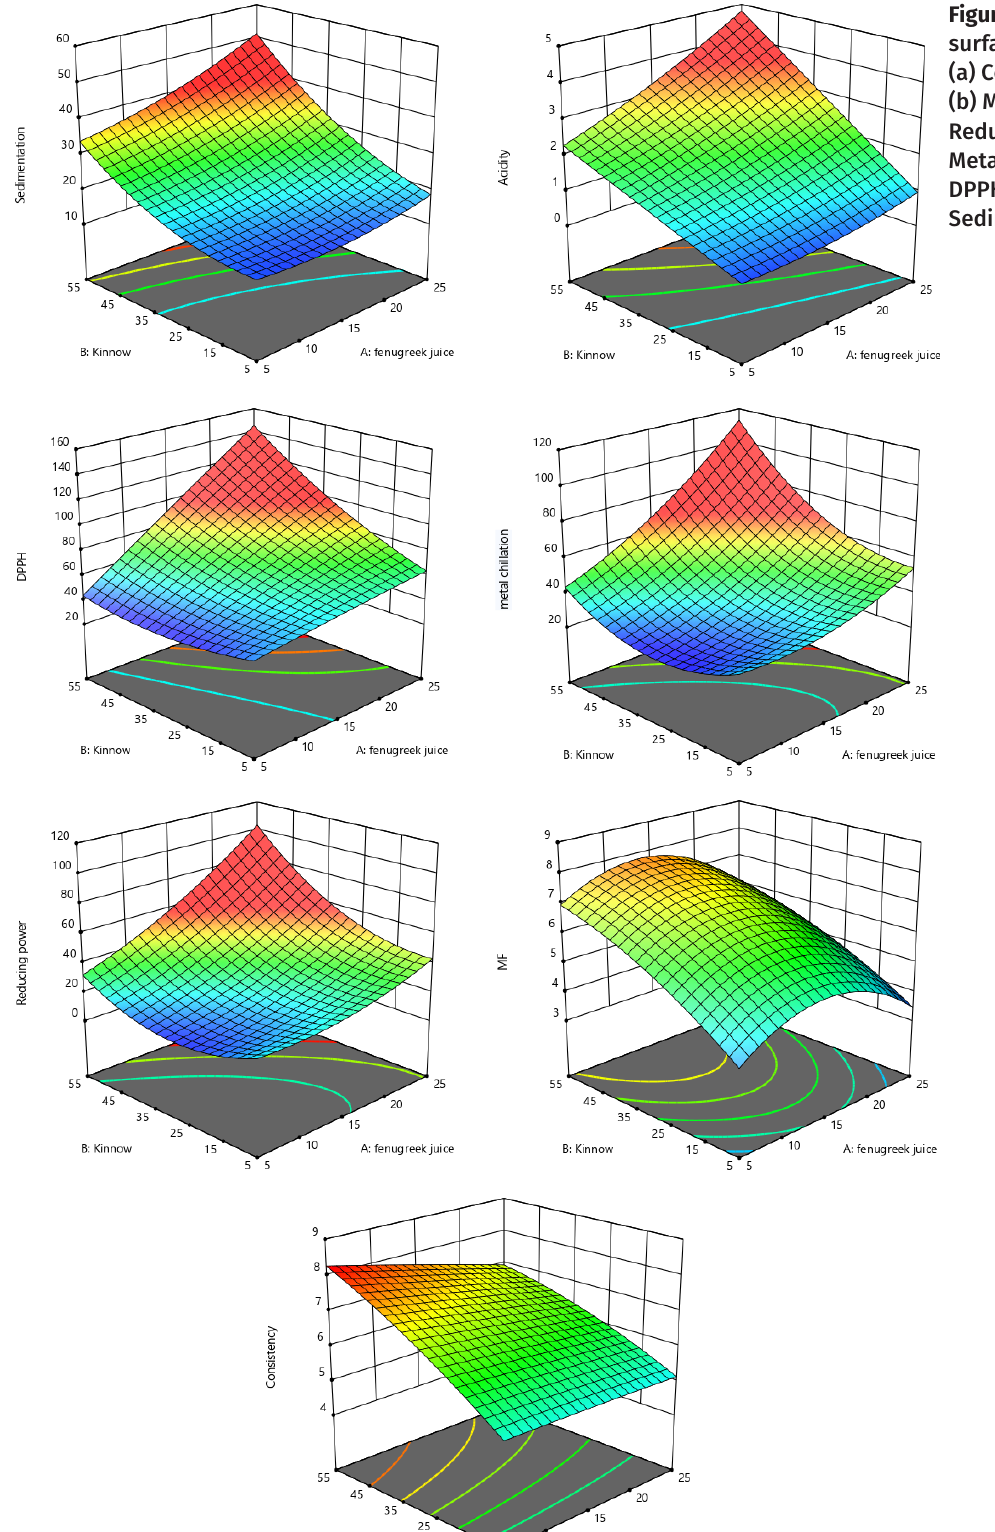
Figure 1. Response surface plots